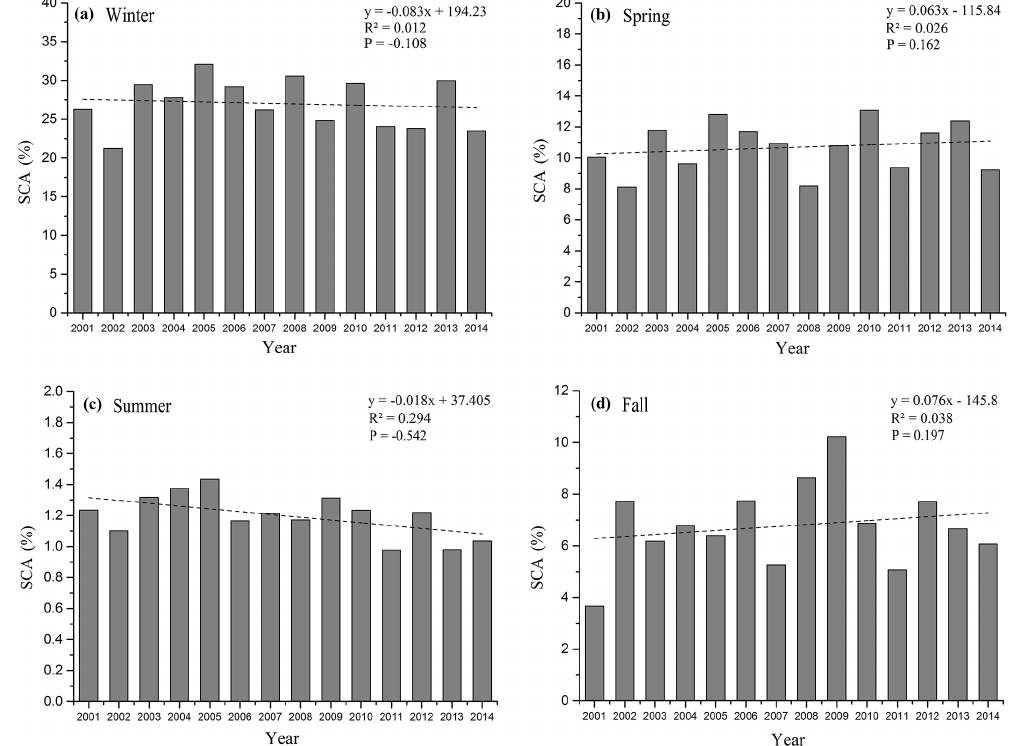
Figure 3. Histograms of the average SCA in each season in China from December 2000 to November 2014. Panels (a) – (d) show the average SCA in winter, spring, summer, and fall, respectively.